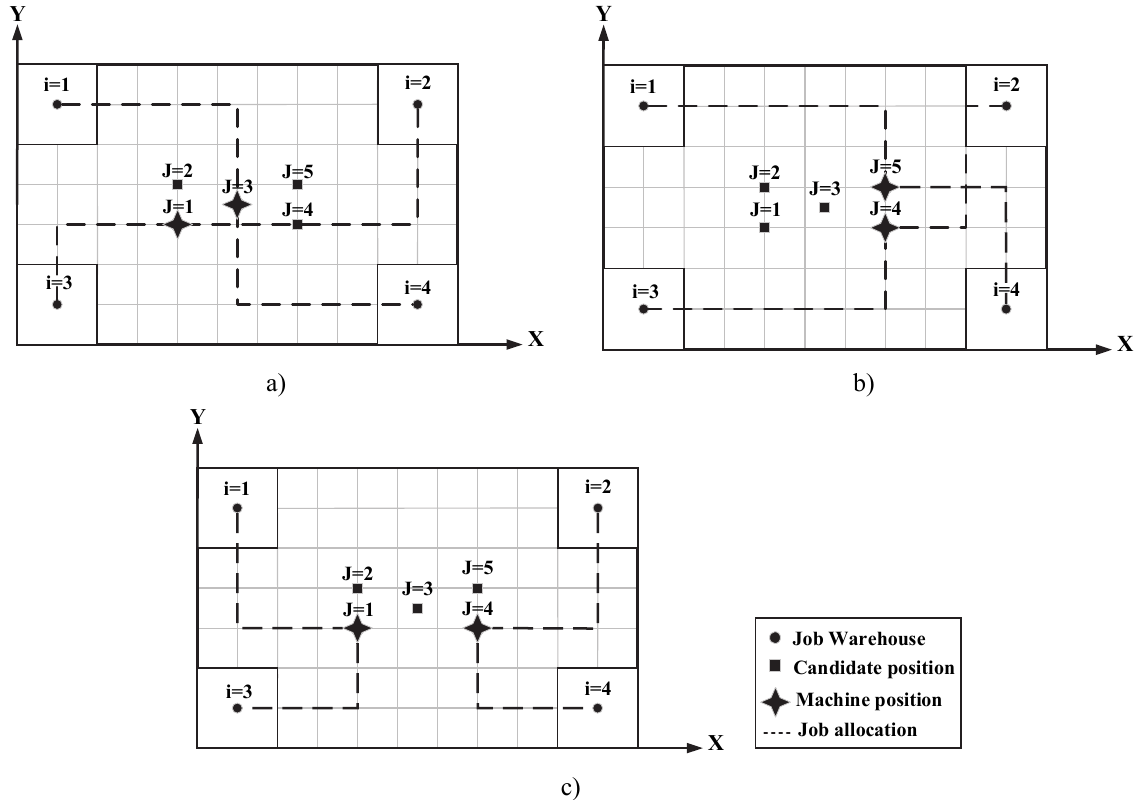
Fig. 3. The locations of the machines and job schedule for discrete case